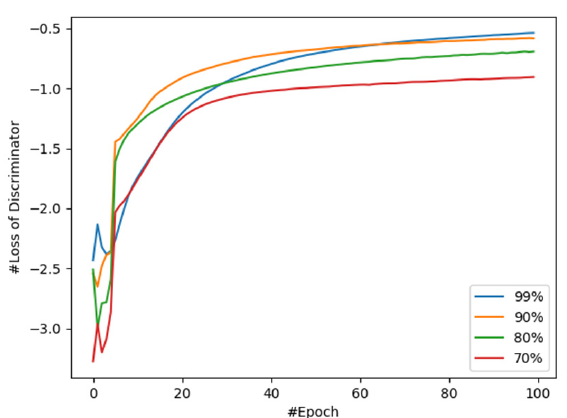
Figure 7. Convergence of discriminator changes as the accuracy of pretrained supervisor changes.